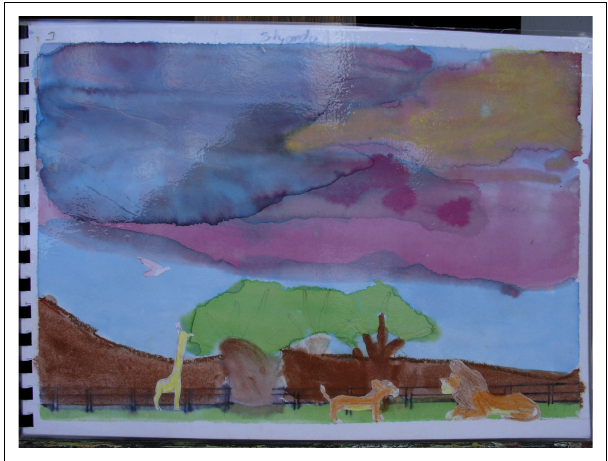
FIGURE 1: Siyanda’s